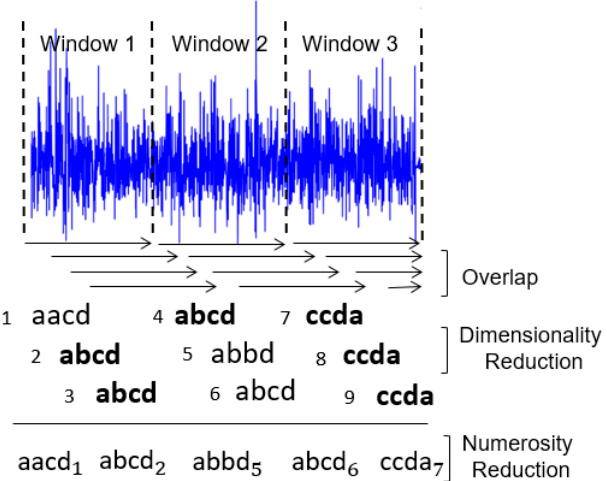
Figure 2. Example of dimensionality and numerosity reduction in a discretized time series represented by words. In this case, the numbers indicate the indexes and the bold words indicate the repeated words.